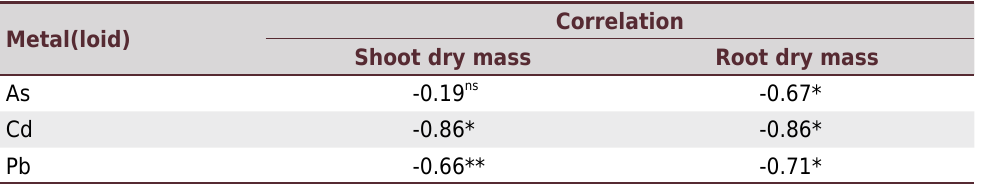
Table 2. Pearson’s simple correlation between heavy metal(loid) and shoot and root dry mass of Sorghum bicolor grown in heavy metal contaminated soil